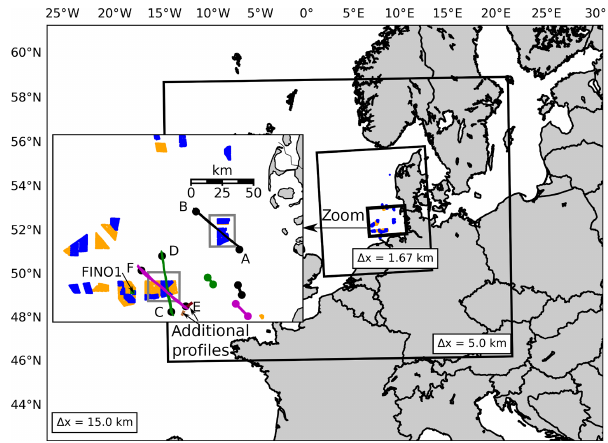
Figure 1. Locations of WRF domains and wind farms at the North Sea. A close-up on the German Bight shows the wind farms of in- terest framed with gray rectangles and the flight tracks of the three measurements in black, green and magenta, corresponding to the measurements executed on 9 August, 14 and 15 October 2017, re- spectively. All measurements over the wind farms have a start and end point indicated with a capital letter for better orientation in Figs. 8, 10 and 11. Blue wind farms are operational; orange wind farms are approved or under construction during the time period in- vestigated in this study. The thick lines indicate the locations of the climb flights, whereby the coloring corresponds to the coloring of the flight tracks over the wind farms, except the light red and red thick line showing the two additional profiles (see annotations) be- fore and after the two additional flight legs. A detailed look (close- up on gray rectangles) at the wind turbine distribution of the wind farms of interest is provided in Fig. 2. The wind turbine location data were provided by the German Federal Maritime and Hydro- graphic Agency (BSH) and Bundesnetzagentur